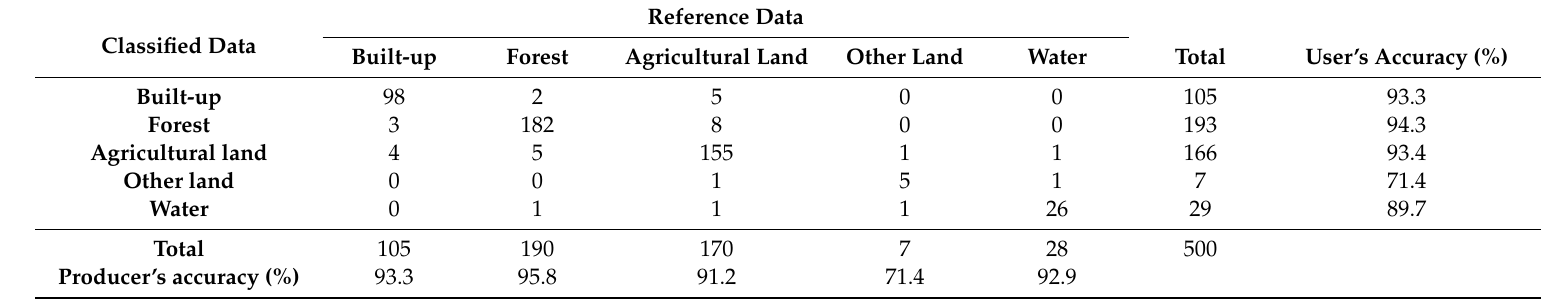
Table A2. Error matrix for the classified 2006 land use / cover